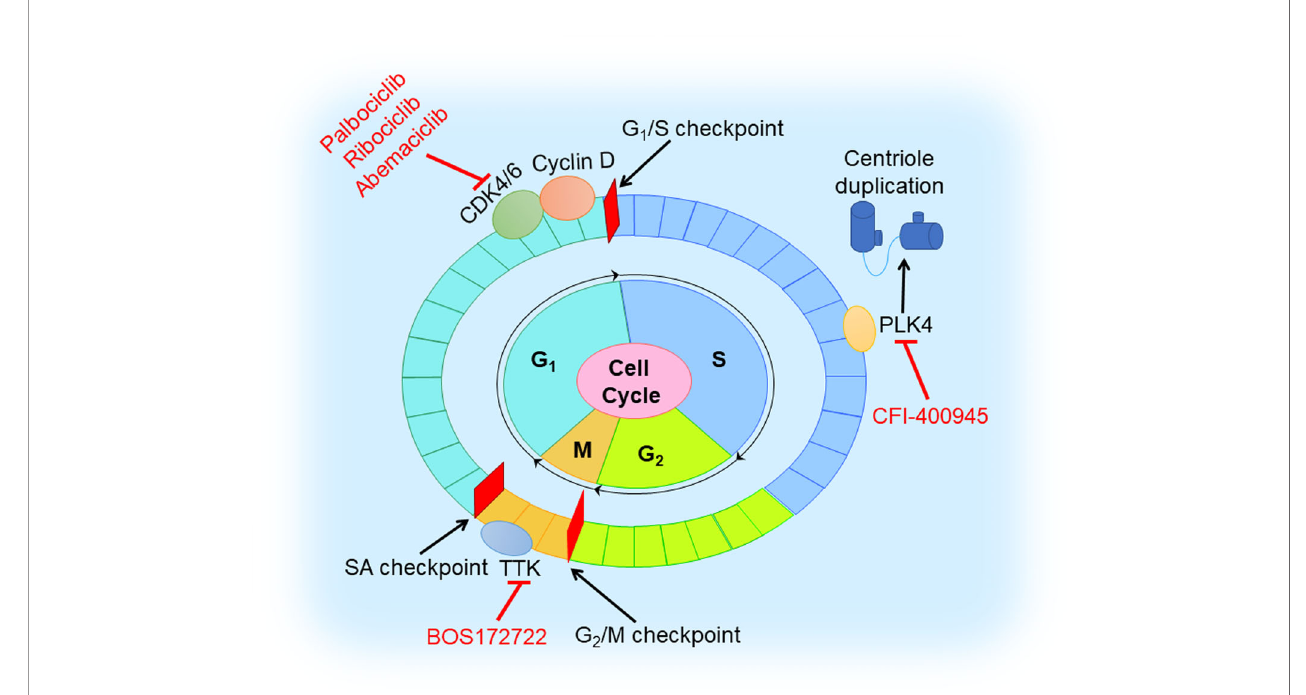
FIGURE 6 | Cell cycle inhibition in TNBC. Cell cycle involves G 1 , S, G 2 , and M phases. CDK4/6 inhibitor (palbociclib, ribociclib, and abemaciclib) blocks the cell cycle at G 1 to S transition by triggering dephosphorylation of retinoblastoma tumor suppressor protein (Rb). TTK inhibitor (BOS172722) binds to TTK that controls the spindle assembly checkpoint. PLK4 inhibitor (CFI-400945) reduces centriole duplication to prevent tumor